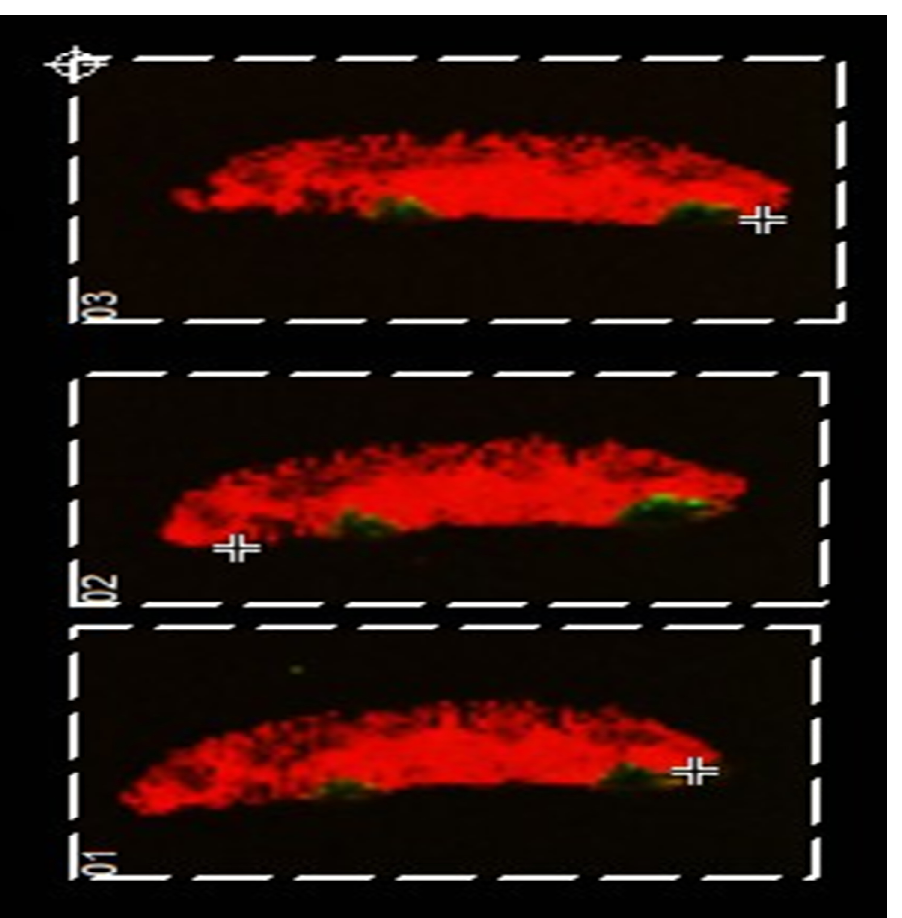
Figure 3. Using the QV600 LLI, porcine small intestinal tissue with the muscle-serosal layer removed was treated with 0.5 mg/mL Atorvastatin over a 6 h period to investigate drug absorption. A MALDI-MS image was generated showing cholesterol [Chol+H-H 2 O] + at m/z 369 in red and protonated molecule of atorvastatin at m/z 559 in green .